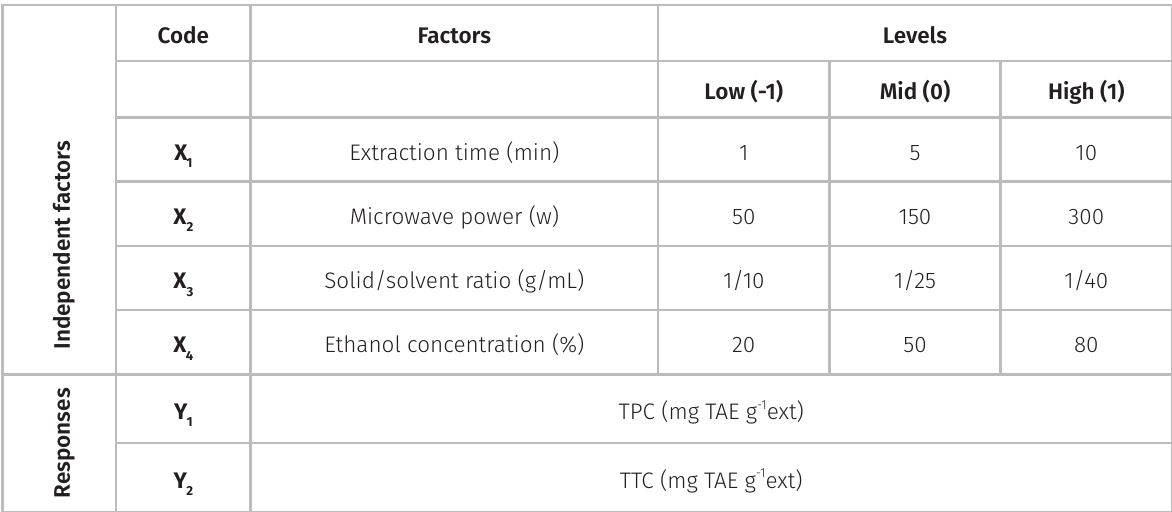
Table I. Independent factors and levels employed in the Box-Behnken experimental design for optimizing TPC